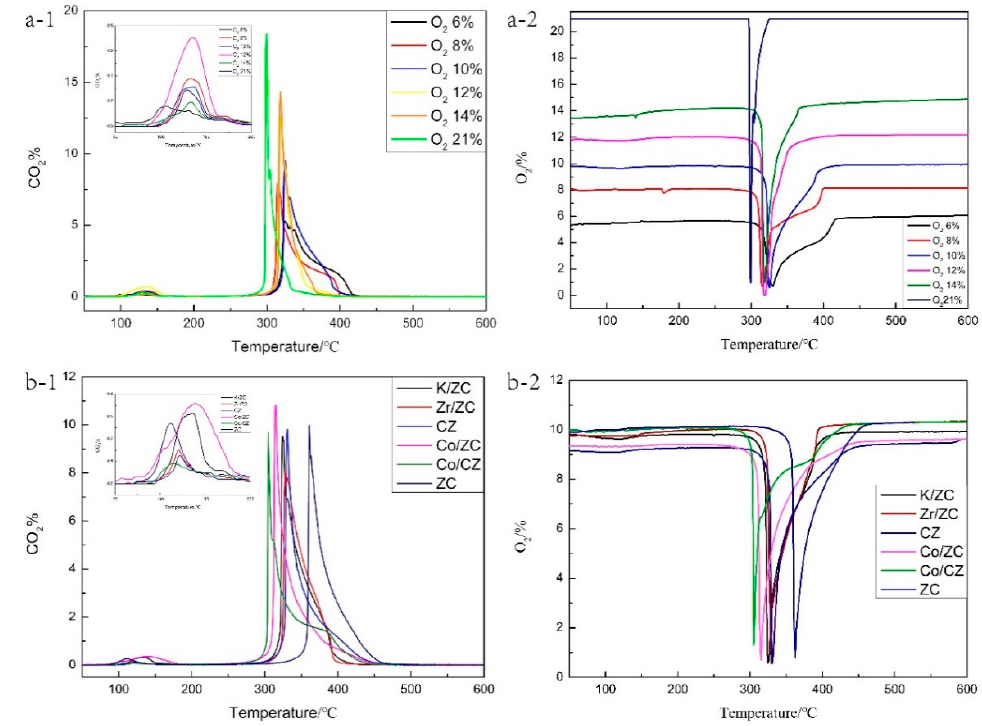
Figure 7. Soot combustion temperature test of ( a-1 ) CO 2 % vs. temperature in different oxygen concentration, ( a-2 ) O 2 % vs. temperature in different oxygen concentration, ( b-1 ) CO 2 % vs. temperature with different catalysts, ( b-2 ) O 2 % vs. temperature with different catalysts. Catalyst used in ( a-1 ) and ( a-2 ), K/ZC.